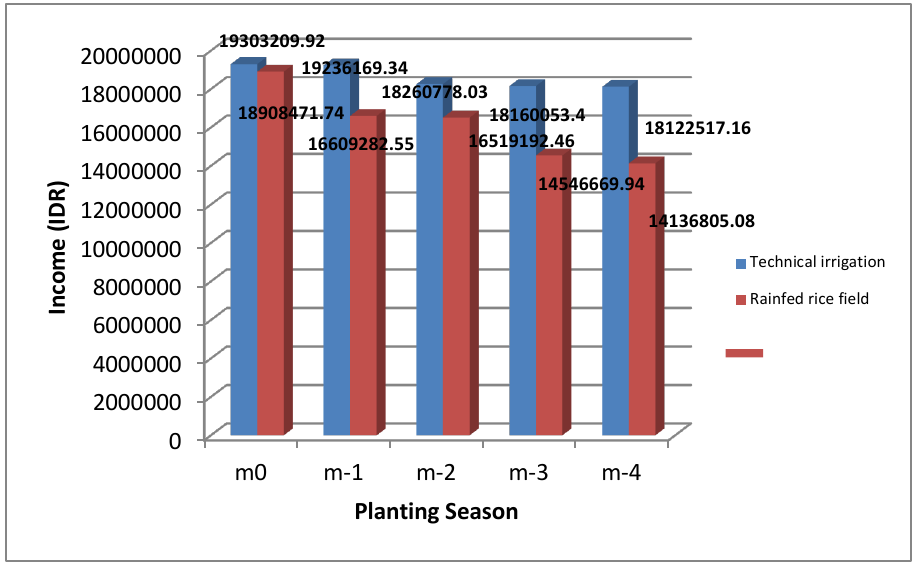
Figure 3: The level of income that wetland paddy farmers received during the rainy season for the last 5 seasons on